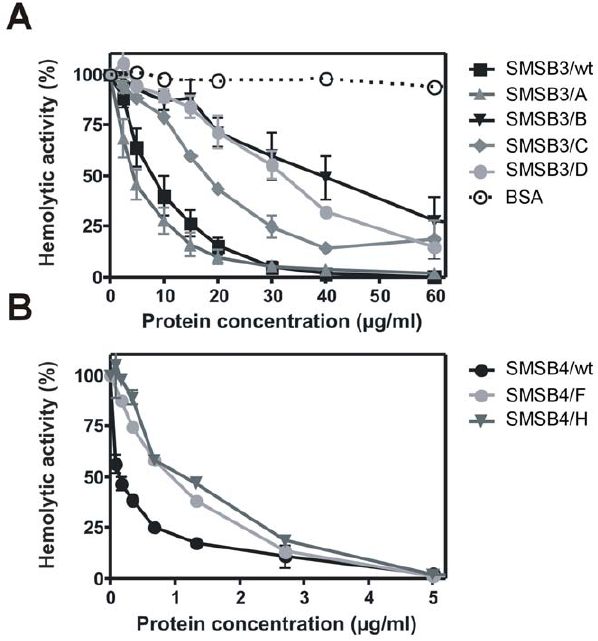
Figure 5. SMSs inhibit the hemolytic activity of human serum. Sheep erythrocytes opsonized with antibodies were incubated with 0.125% NHS to visualize the activity of the classical pathway of the human complement system. Serum was pre-incubated for 10 min at 37 u C with various concentrations (2.5–60 m g/ml, i.e. 54–1300 nM) of SMSB3 and its four mutants ( A ), SMSB4 and its two mutants (0.1–5 m g/ ml, i.e. 2–93 nM) ( B ) and BSA as a negative control. After 1 h of incubation of NHS with erythrocytes at 37 u C, the degree of complement-mediated lysis was estimated by measurement of released hemoglobin. The lysis obtained in the absence of SMSs was defined as 100% hemolytic activity. An average of three independent experiments performed in duplicate is presented with bars indicating